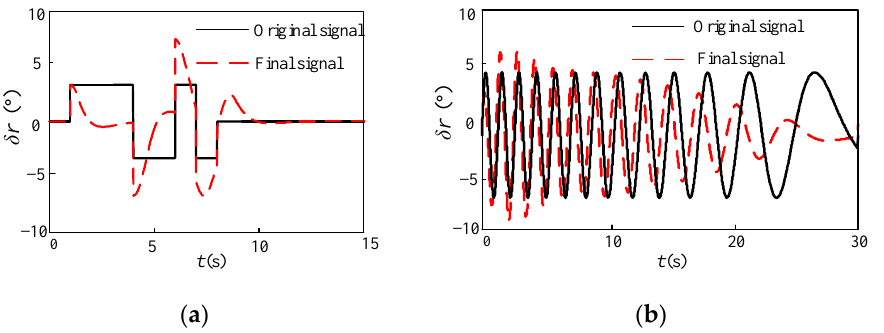
Figure 7. Shape changes of two signal types in the time domain. ( a ) The 3211-multipole square wave; ( b ) Frequency sweep.